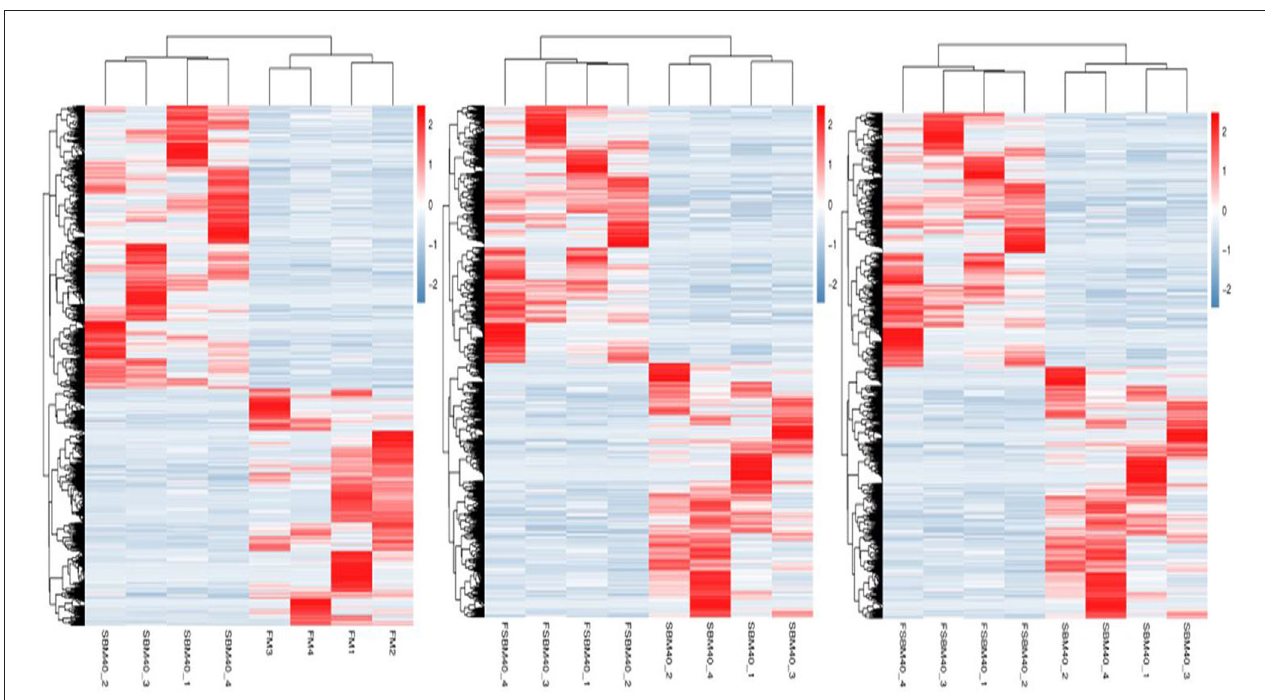
FIGURE 2 | Cluster heat map of significantly differential genes in hindgut of pearl gentian grouper at different substitution levels of fermented soybean meal ( n = 4).